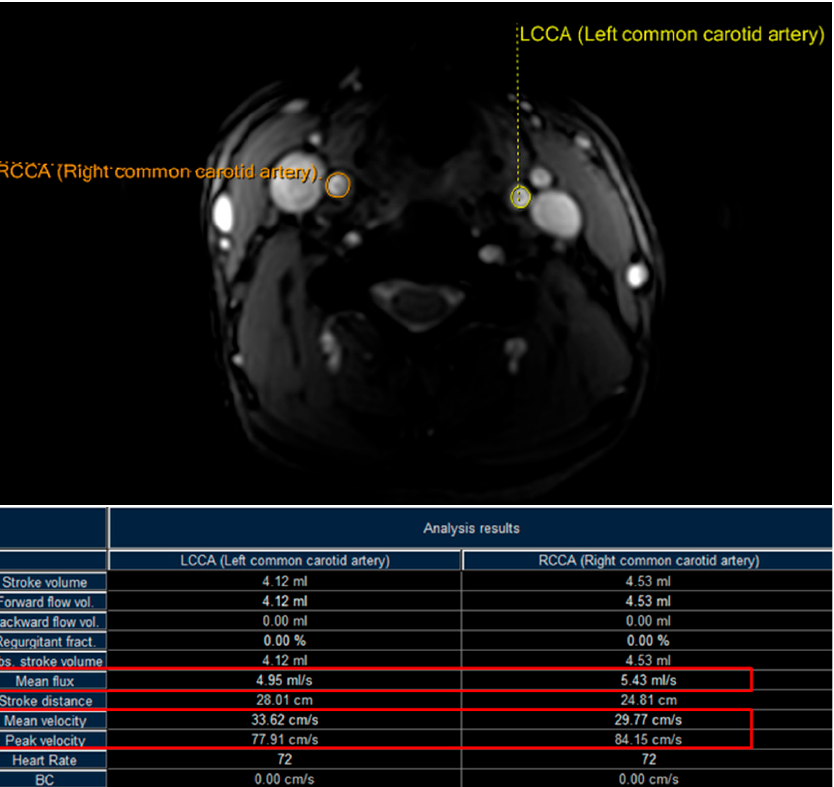
Figure 3. PC-MRI measurements of both the left and right common carotid arteries for the maximum and time-averaged mean velocities, and volume flow rate (“Peak velocity”, “Mean velocity”, and “Mean flux” denoted in the figure).